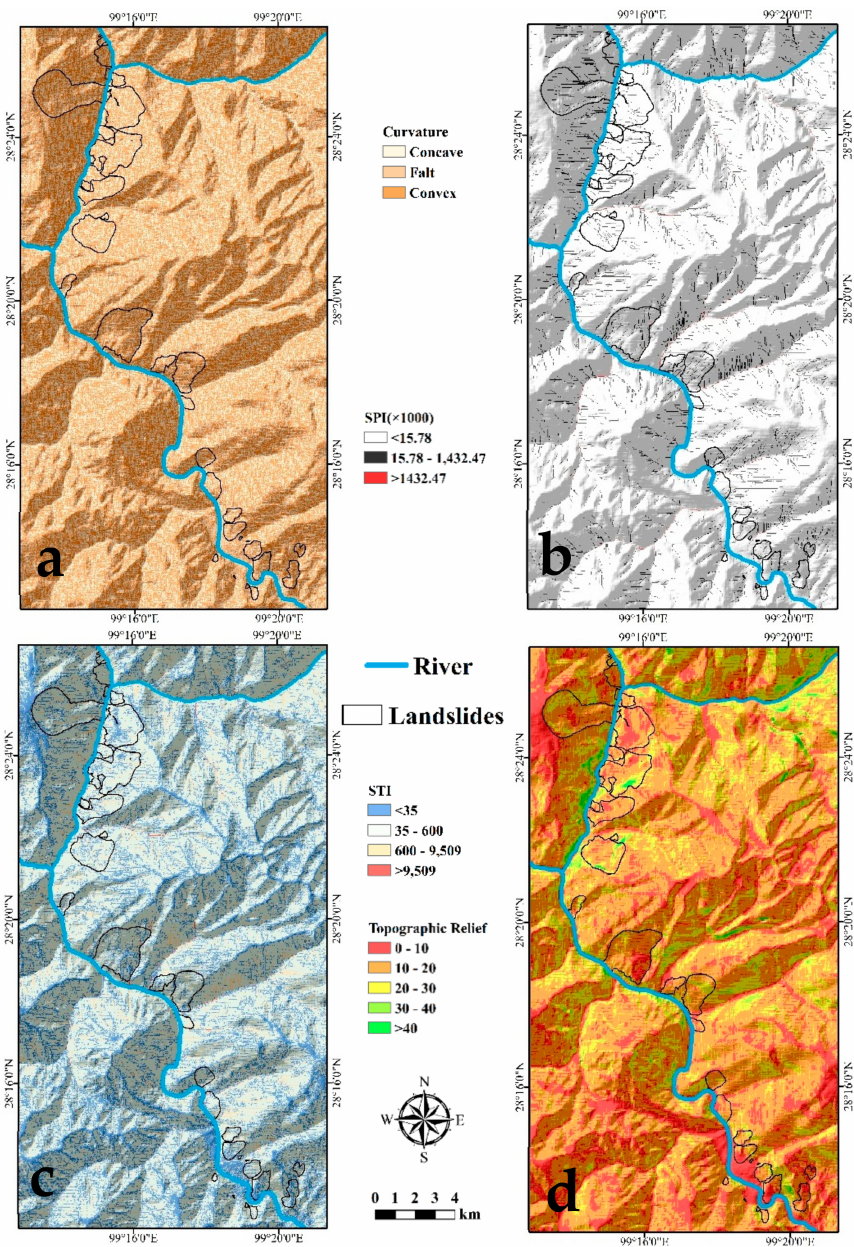
Figure 5. Influencing factor maps of the study area: ( a ) curvature; ( b ) steam power index (SPI); ( c ) sediment transport index (STI); and ( d ) topographic